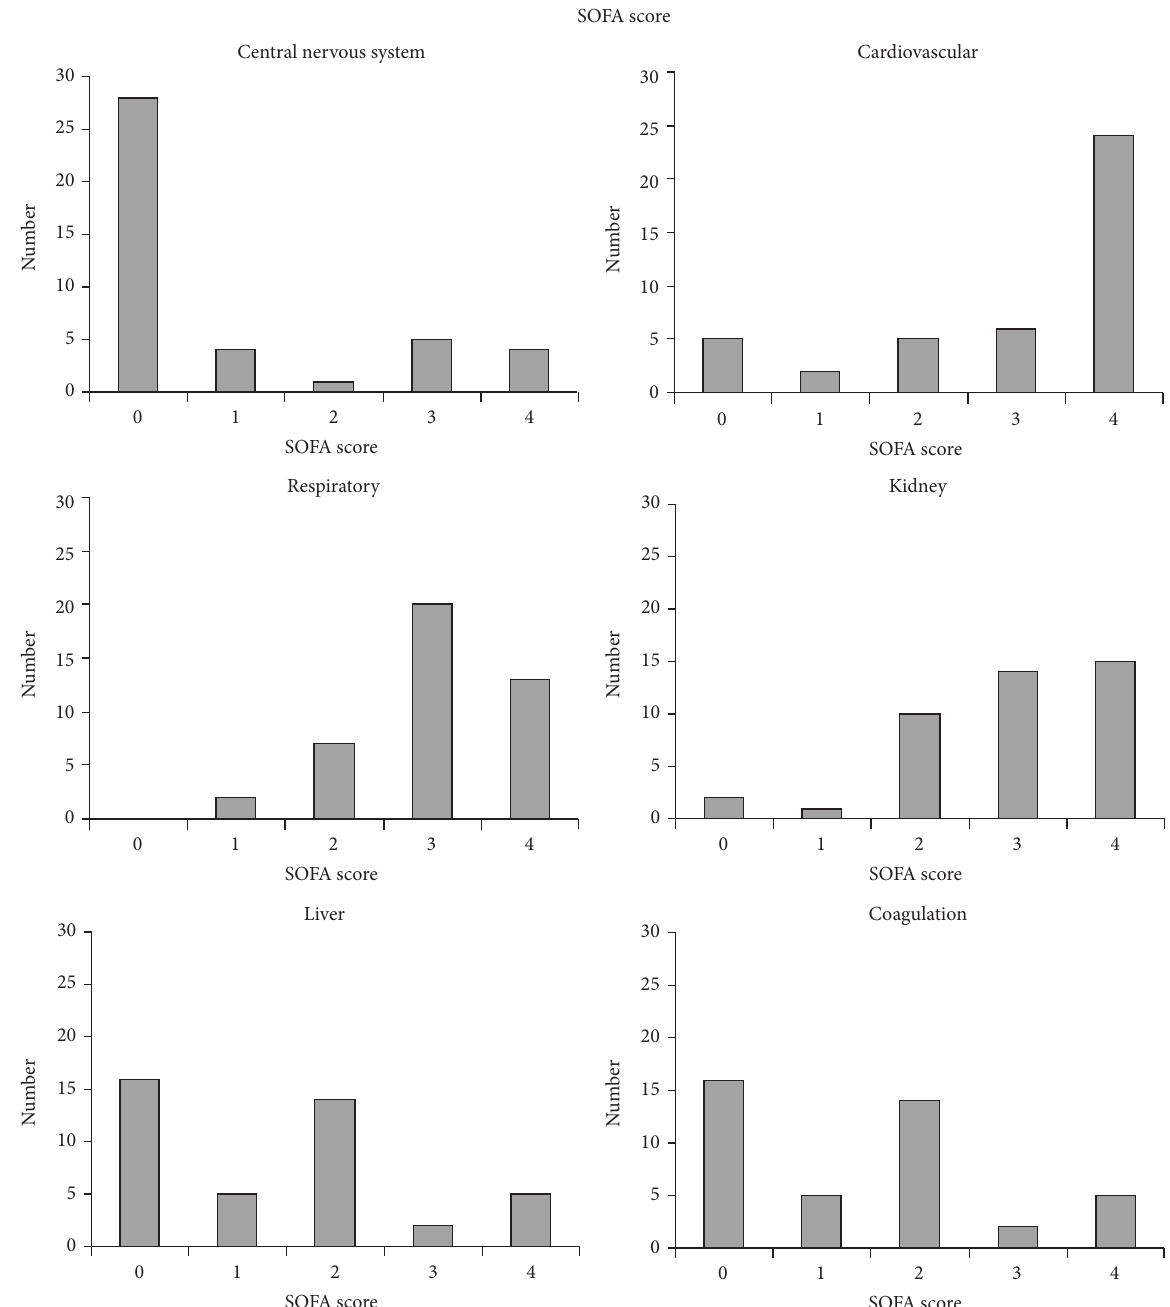
Figure 1: The organ failures measured by sequential organ failure assessment (SOFA) score in trauma patients with acute kidney injury and need of continuous renal replacement therapy ( 𝑛 = 42 ). Data is presented as number of patients having SOFA score 0–4 for the six measured organ functions at the time of initiation of continuous renal replacement